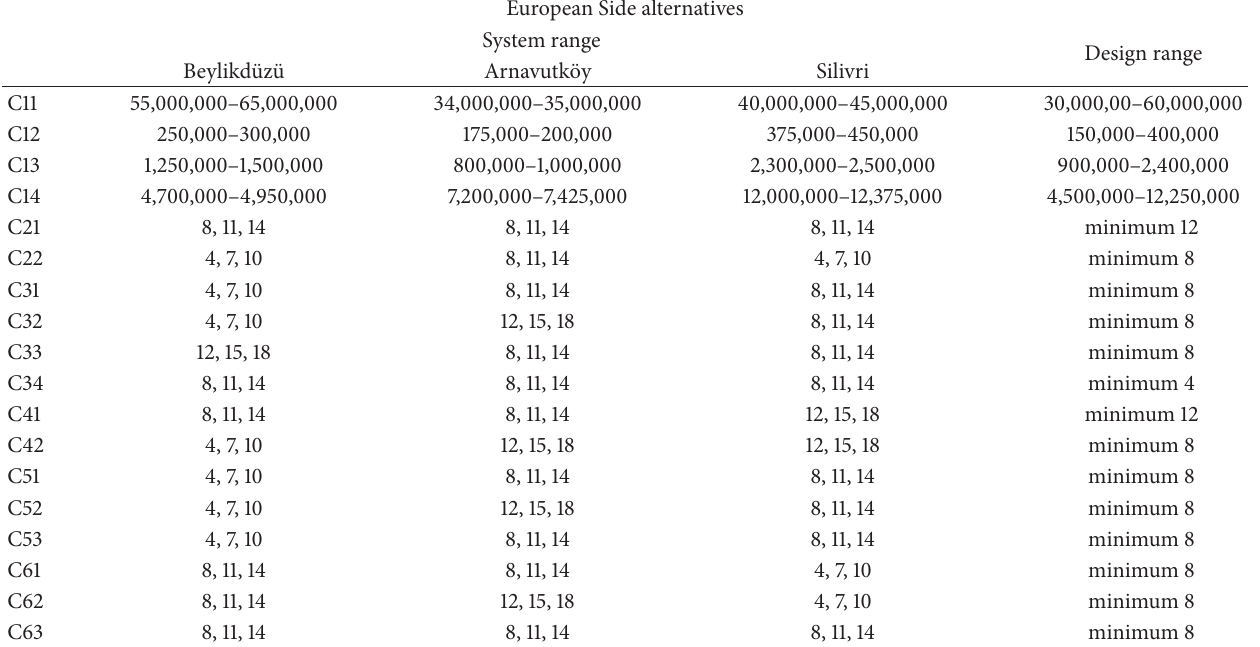
Table 6: The system and design range for European Side of Istanbul.